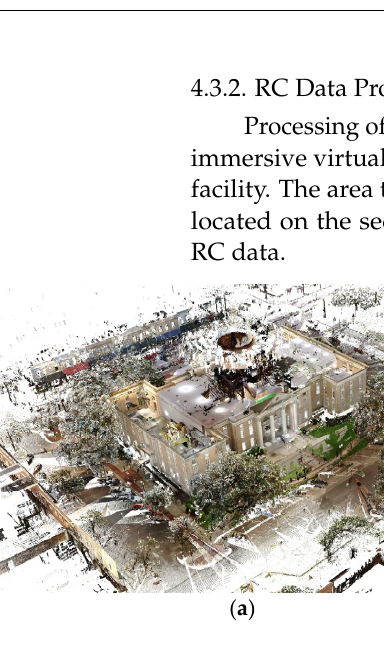
Figure 24. Semantic data capture of the OPCC: ( a ) basement floor plan of the original 1908 blue ‐ prints; ( b ) 1908 blueprint of southeast basement wall; ( c ) 1908 blueprint of Type ‐ H foundation with 22 in (0.56 m) wall; ( d ) 1995 renovation showing exposed wall section; ( e ) measurement of the constructed wall section.